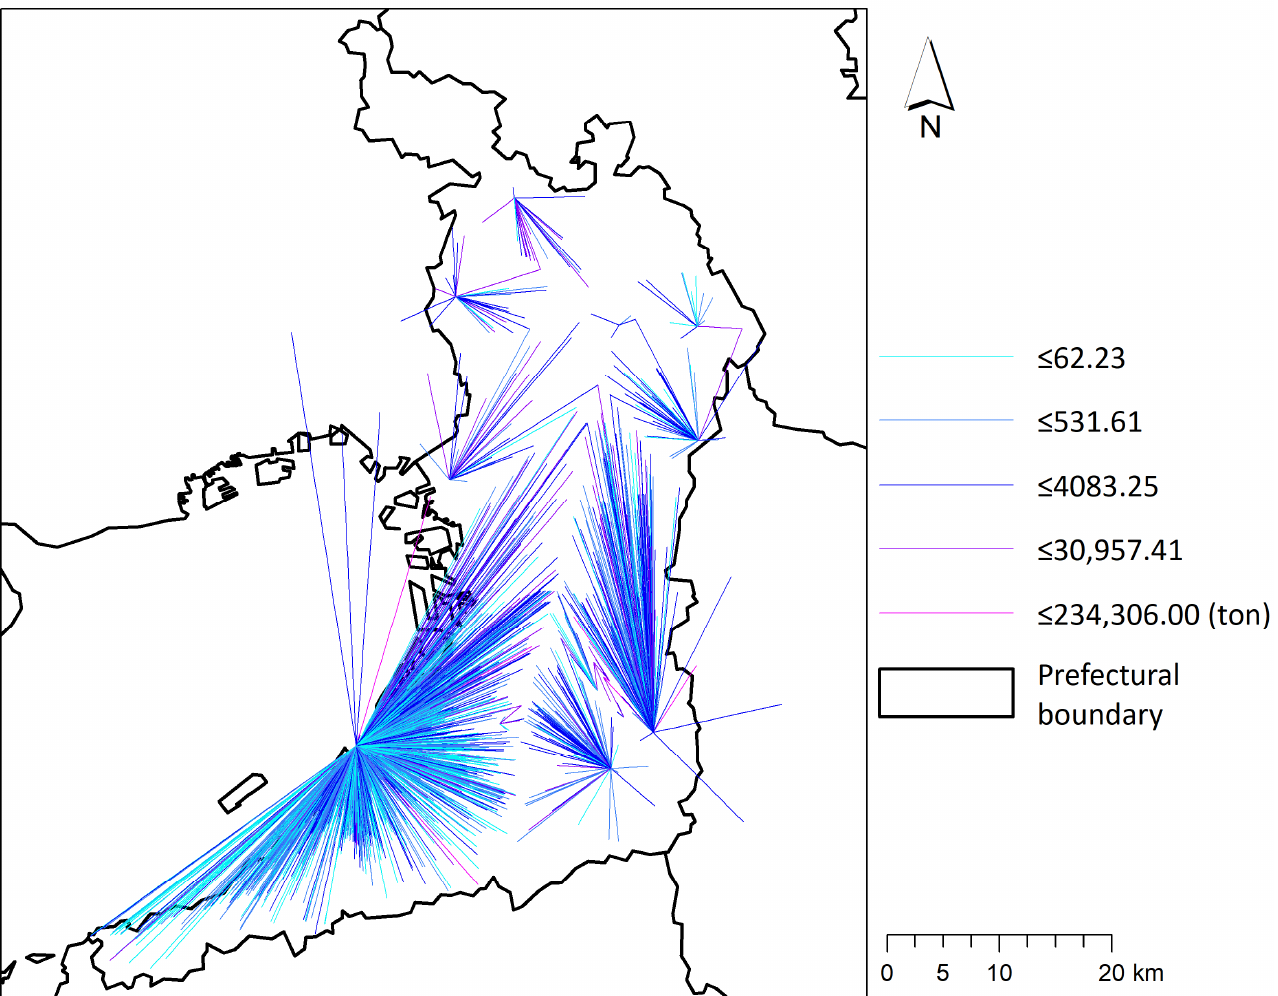
Figure 10. Fill material flows optimized for the shortest total distance.